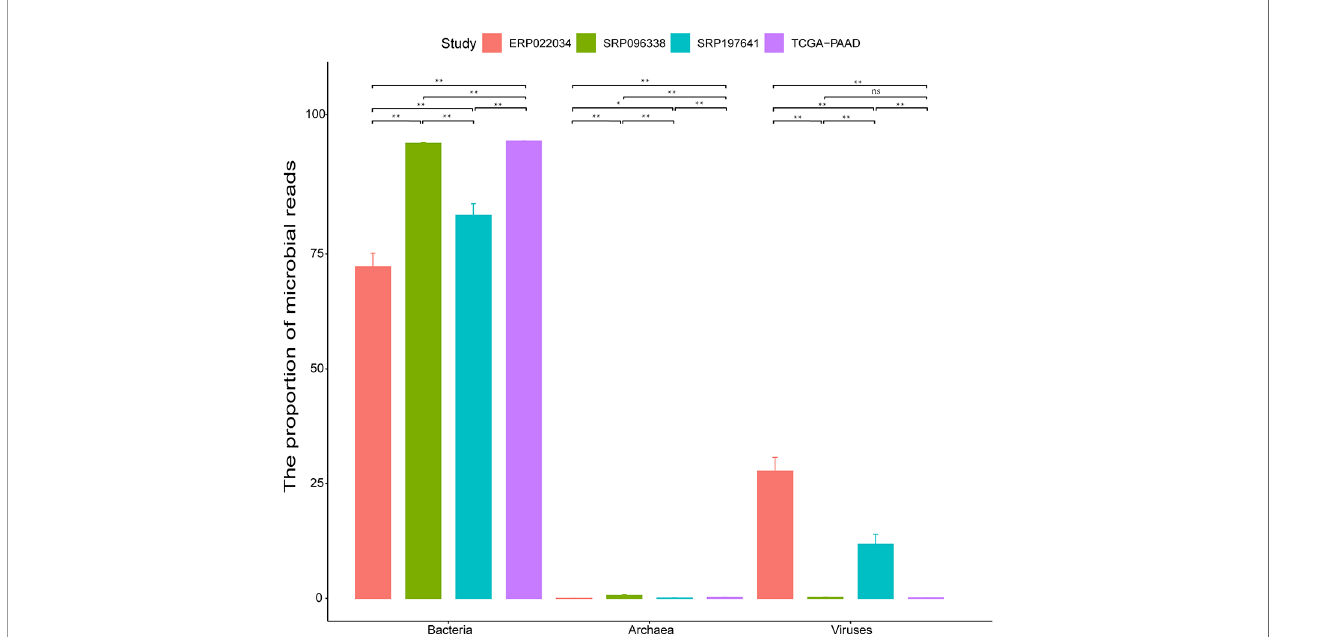
FIGURE 2 | The proportion (%) of bacteria, viruses, and archaea in identi fi ed microbial reads in each dataset. The standard deviation is plotted on the graph. Statistical analysis is conducted using the Wilcoxon signed rank test. The sign ‘ ** ’ means p-value <0.01, and ‘ * ’ means p-value <0.05. ‘ ns ’ means Not Signi fi